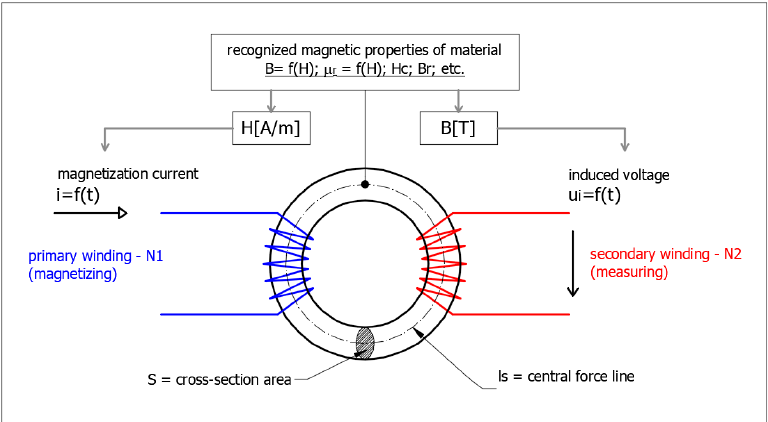
Figure 3. Graphical illustration of remagraph—The basic block diagram of a measuring system.